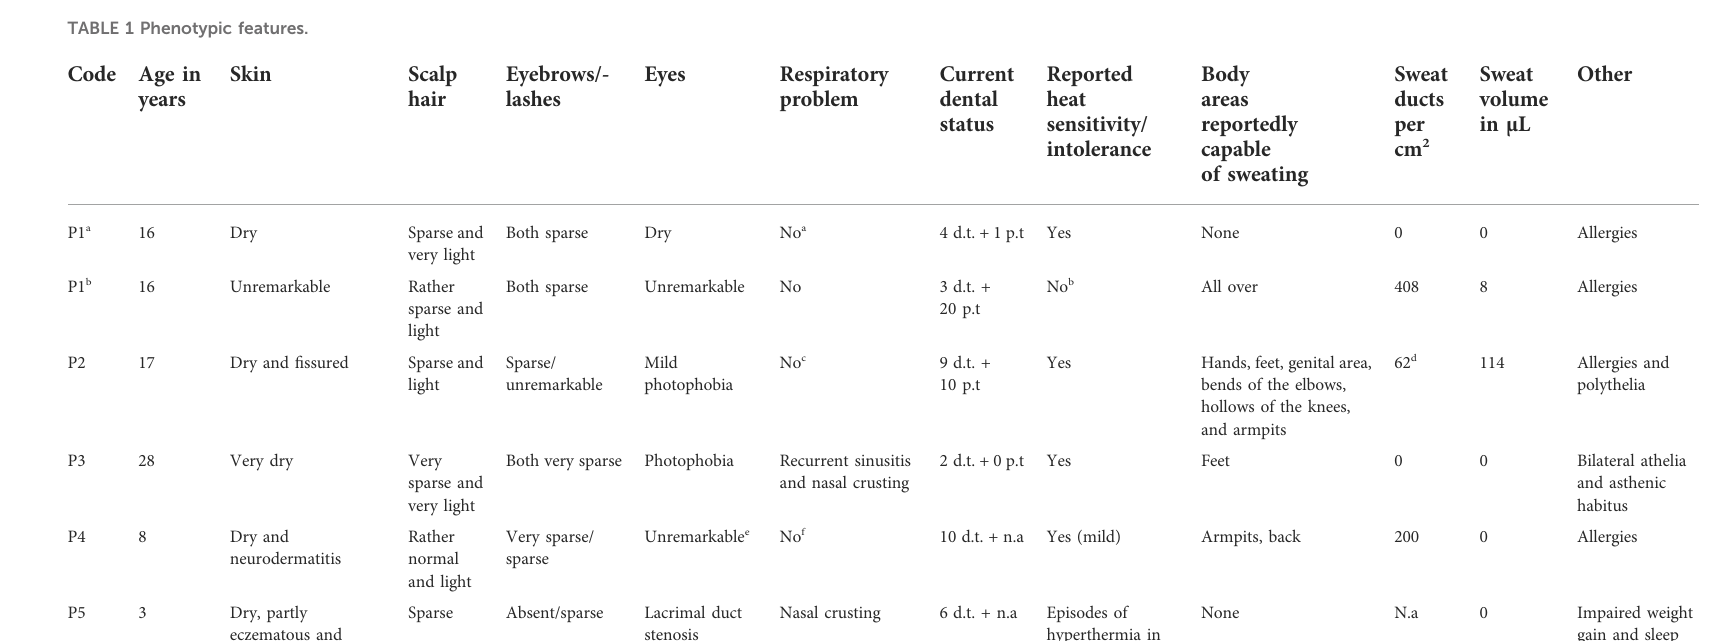
TABLE 1 Phenotypic